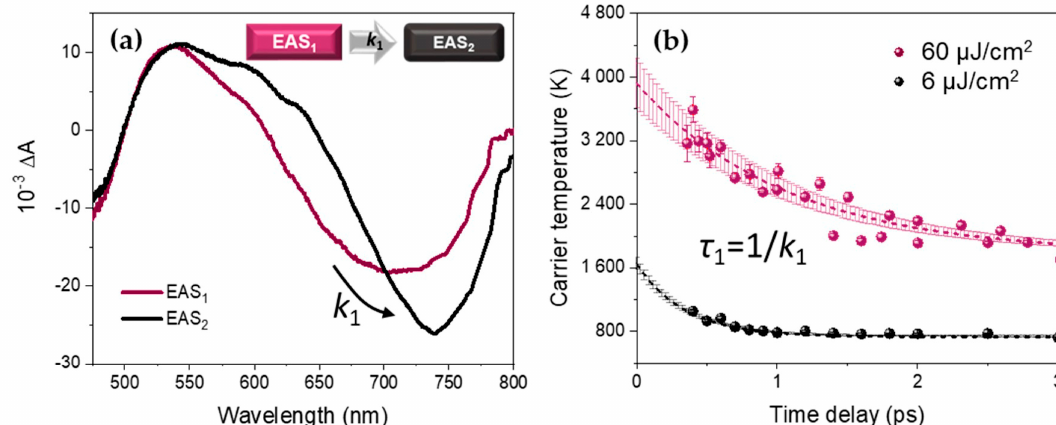
Figure 3. ( a ) Evolution Associated Spectra EAS 1 and EAS 2 related by the relaxation constant k 1 extracted by the global analysis from the TA data of thick FAPbI 3 NPs (here for an excitation fluence of 60 µ J / cm 2 ). ( b ) Comparison between T c extracted from the conventional analysis (dots) and the exponential simulation using global fit parameters (dashed lines with the associated incertitude in the shaded area) at 6 µ J / cm 2 (black) and 60 µ J / cm 2 (purple) excitation fluence, using Equation (4).